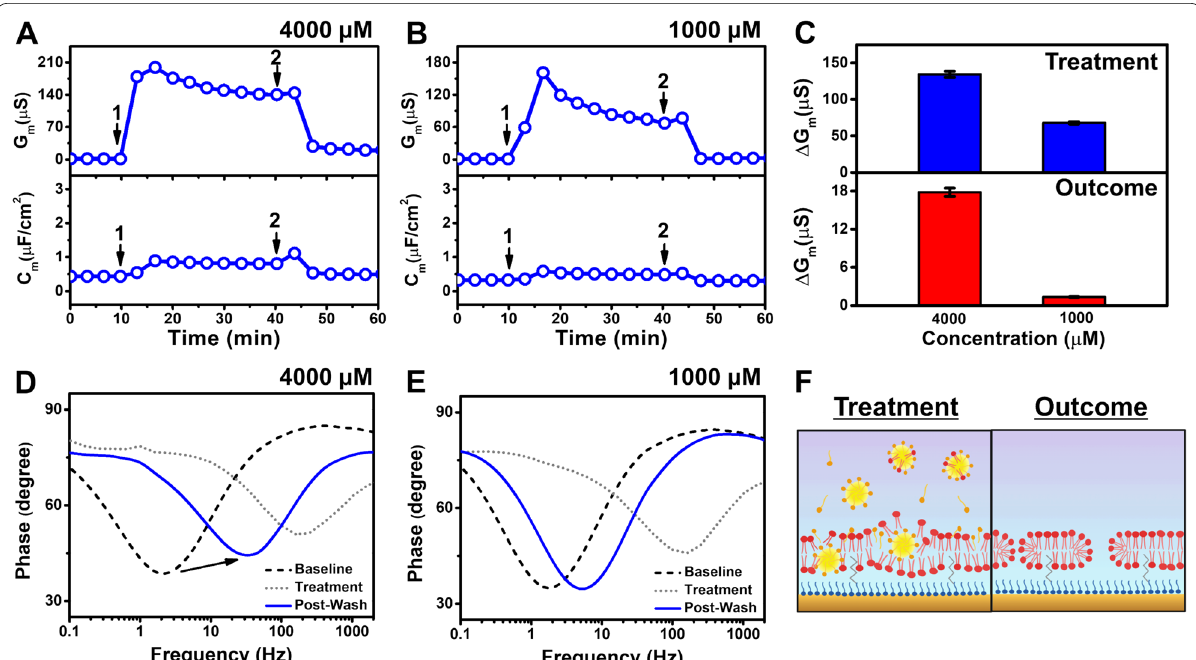
Fig. 7 EIS investigation of adding higher monoundecanoin concentrations to the tBLM platform. Time‑resolve changes in conductance (G m ) and capacitance (C m ) signals following the addition of ( A ) 4000 µM and ( B ) 1000 µM monoundecanoin to the tBLM platform. The initial baseline measurements correspond to the fabricated tBLM platform in PBS solution on the gold electrode. After 10 min of establishing the baseline signals, monoundecanoin was added (arrow 1) and incubated for 30 min before buffer washing was performed (arrow 2). C Summary of G m shifts upon compound addition (top panel) and after buffer washing (bottom panel) relative to the tBLM baselines. Bode plots describing the phase shifts of the system from baseline signals in response to treatment with ( D ) 4000 µM or ( E ) 1000 µM monoundecanoin and buffer washing. F Schematic illustration based on the EIS data of how 4000 µM monoundecanoin interacts with the tBLM and the resulting tBLM after monoundecanoin was removed by buffer